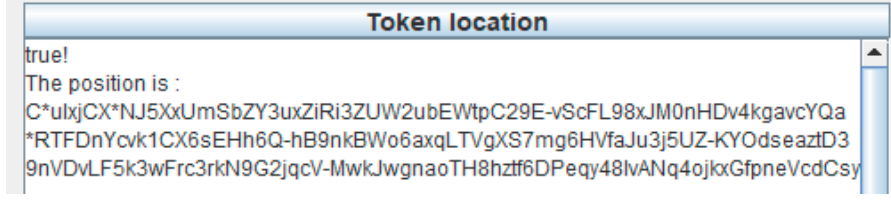
Figure 26. Result of message token location.